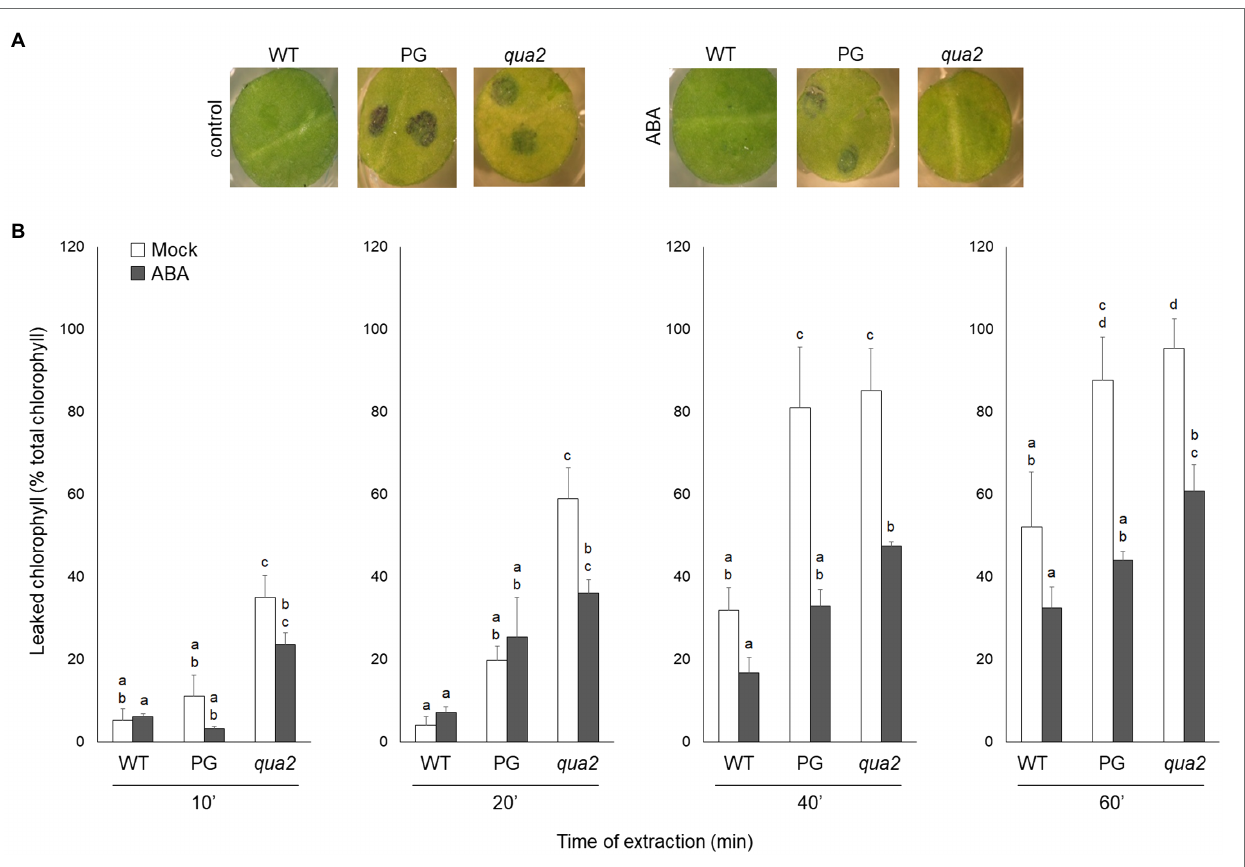
FIGURE 1 | Plants with altered HG have increased leaf cuticle permeability that is suppressed by exogenous ABA. (A,B) , WT, PG, and qua2 five-week-old plants were sprayed with 0.01% MeOH or 100 μ m ABA and, after 24 h, rosette leaves were collected. (A) , Leaf disks were stained with droplets of toluidine blue and washed with water. (B) , Leaves were incubated for the indicated times with 80% EtOH and the percentage of total chlorophyll released in the medium was spectrophotometrically measured. Bars indicate average percentage of total chlorophyll leaked at the indicated time of incubation ± SD ( n = 3). For each time point, letters indicate statistically significant differences, according to two-way ANOVA followed by Tukey’s significance test ( p < 0.05). These experiments were repeated three times with similar